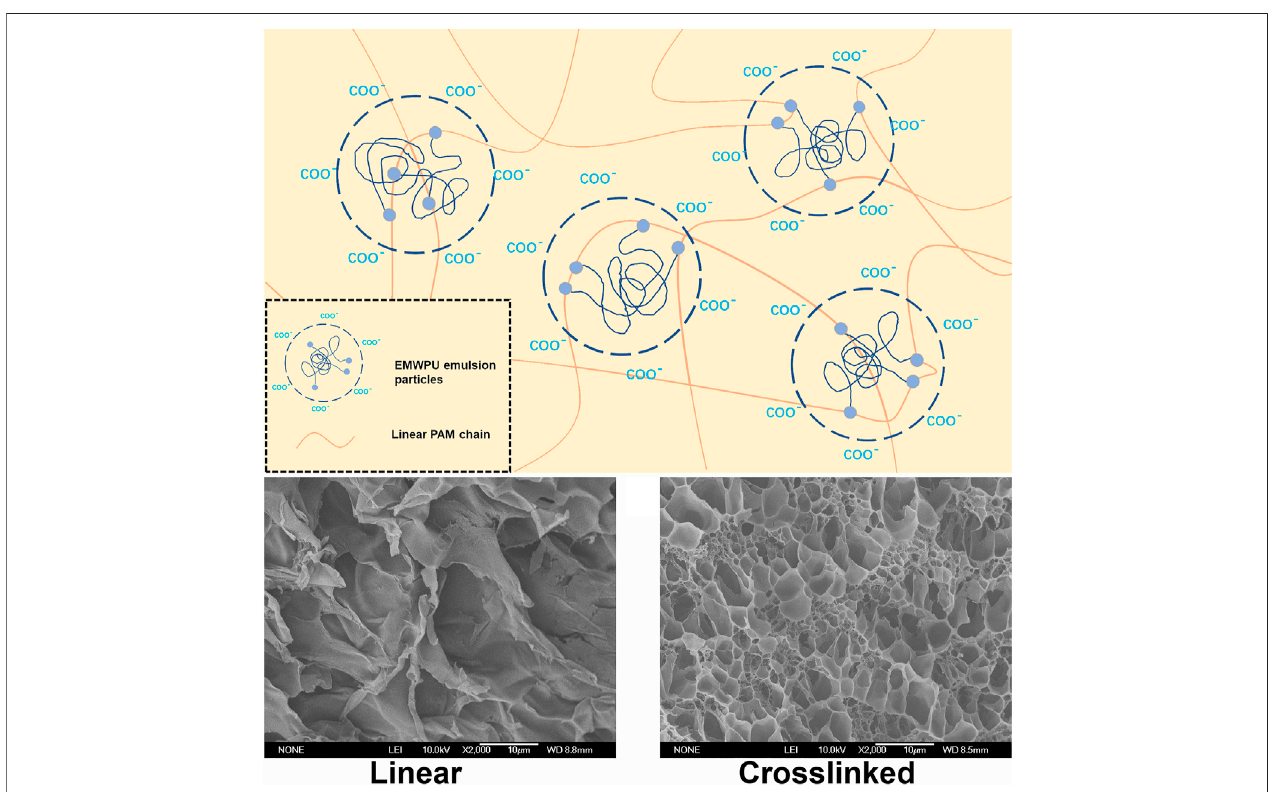
FIGURE 5 | (A) Schematic of EMUPUG crosslinking mechanism; SEM images of (B) linear PAM hydrogel and (C) Crosslinked EMWPUG ( R = 1.32, 1.25%).